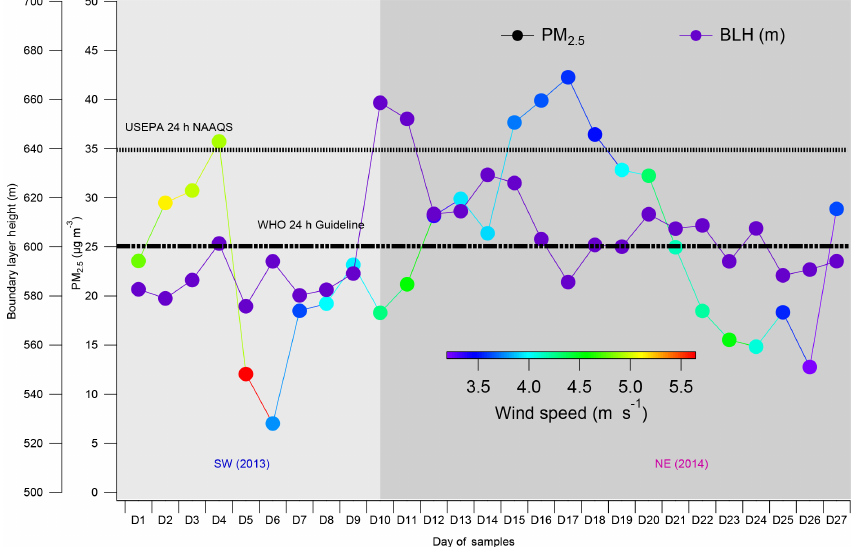
Figure 4. Time series of 24h averages of PM 2 . 5 , wind speed (ms − 1 ), and yearly daily mean of the boundary layer height (BLH) over the region of Peninsular